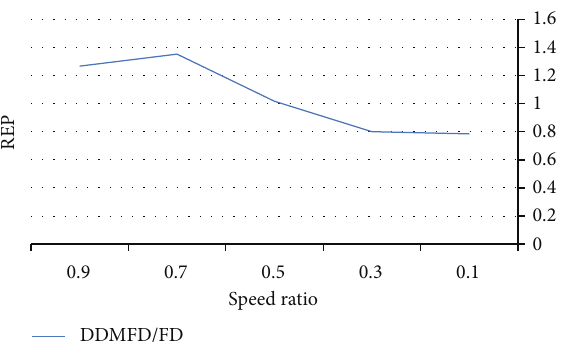
changes in different scenarios with adj , FD & ddmfd